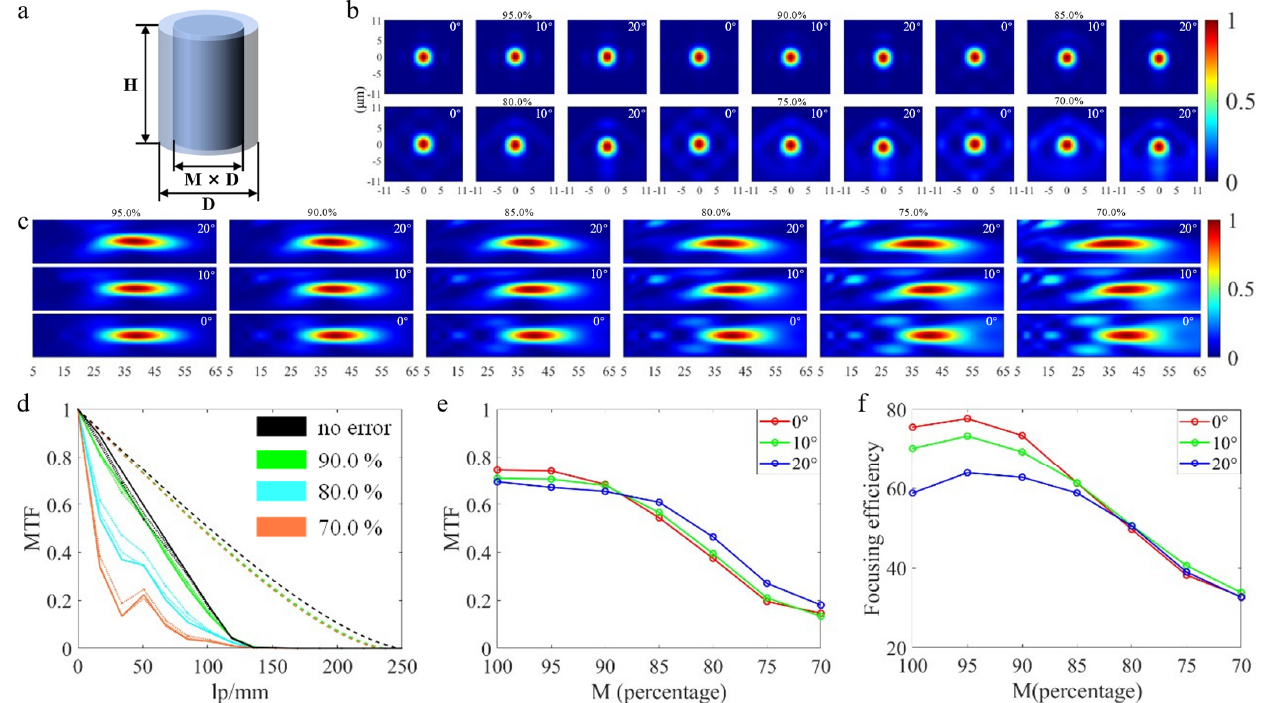
Figure 4. ( a ) Schematic diagram of CD bias error. ( b , c ) Light intensity distribution along XY and XZ direction at different FOV under various error conditions. ( d ) MTF curves at different FOV under various error and no − error conditions, the double dash line represents the diffraction limit, the solid line represents the 0° FOV, the dash line represents the 10° FOV, the dot − dashed line represents the 20° FOV (the diffraction limit at 80.0% error coincides with that at 70.0% error). ( e ) Line chart of MTF values at different FOV under various error and the no − error conditions when the frequency is 33.33 lp/mm. ( f ) Focusing efficiency at different FOV under various error and no − error conditions.